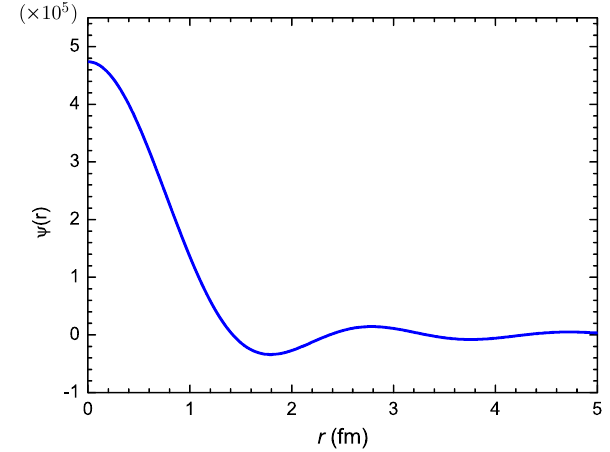
Fig. 2 Wave function (cid:22)( r ) corresponding to channel (cid:7) b D